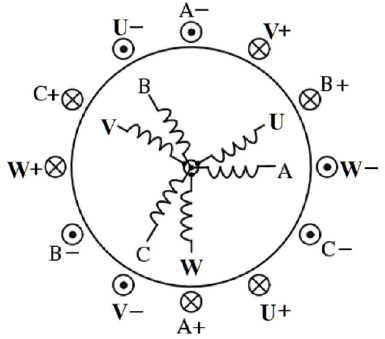
Figure 1. Block diagram of the fault-tolerant control strategy.